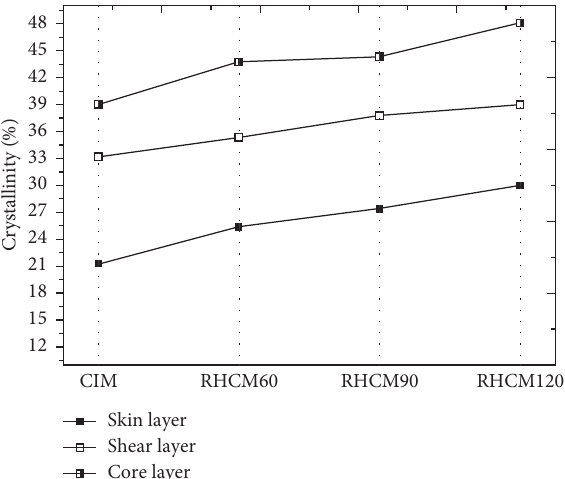
Figure 8: Statistical results of crystallinity in each layer in CIM and RHCM